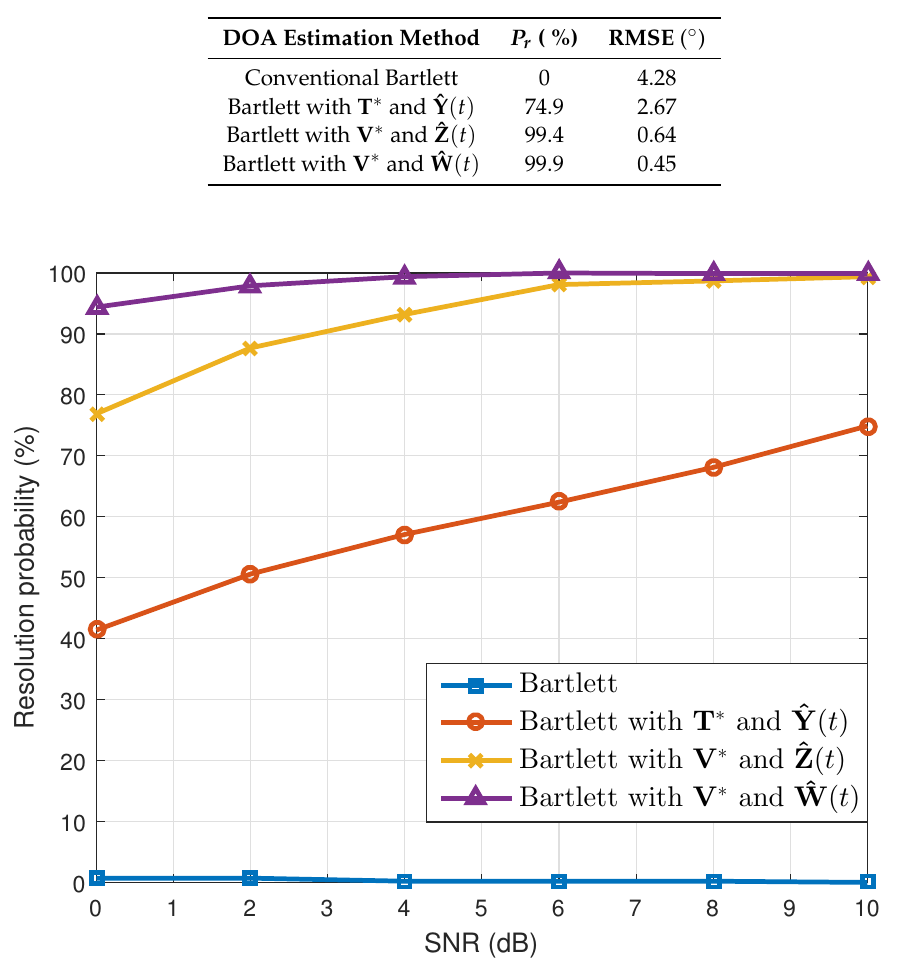
Table 1. Resolution probabilities and root mean squared errors for two adjacent targets located at [ − 3.5 ◦ , 2.5 ◦ ] .